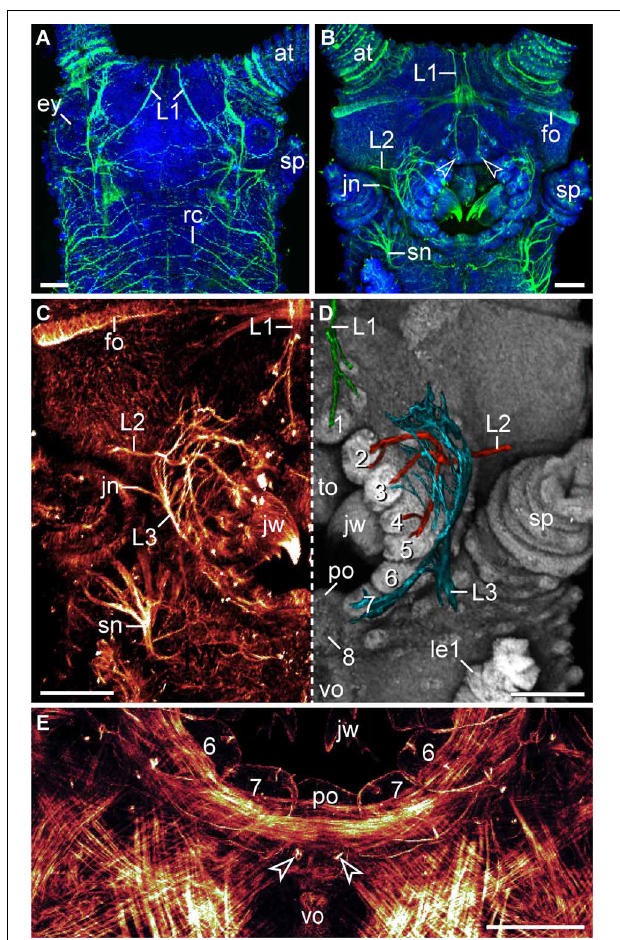
FIGURE 5 | Characteristics of nerves supplying the lip papillae in Euperipatoides rowelli . Maximum projection confocal micrographs of a late stage VII embryo. (A,B) Head in dorsal and ventral views, respectively. Double-labeling with an acetylated α -tubulin antibody (green) and the DNA marker Bisbenzimide (blue). Note the first pair of lip papillae nerves (L1) that originates dorsally and projects ventrally to supply the anterior-most lip papillae (arrowheads). (C,D) Details of the same embryo as in (B) . (C) Anti-acetylated α -tubulin immunolabeling (glow mode). Note the dense network of fibers formed by the second (L2) and third lip papillae nerves (L3). (D) The same portion of the embryo as in (C) but mirrored. The three lip papillae nerves (L1, L2, and L3, highlighted by artificial colors) were superimposed on the DNA-labeled surface of the head to illustrate their relationship to the lip papillae. (E) Ventral mouth portion of an embryo in ventral view to demonstrate the origin of the posterior most lip papilla (number 8) from a paired anlage (arrowheads). The lateral lip papillae surrounding the mouth opening are numbered. Note that the paired anlage occupies a position between the ventral and the preventral organs of the slime papilla segment. Phalloidin-rhodamine labeling. Abbreviations: at, antenna; ey, eye; fo, developing frontal organ; jn, jaw nerve; jw, jaw; L1–L3, lip papillae nerves 1–3; le1, first walking leg; po, preventral organ; rc, ring commissure; sn, slime papilla nerve; sp, slime papilla; to, tongue; vo, ventral organ. Scale bars: 100 μ m (A–E)